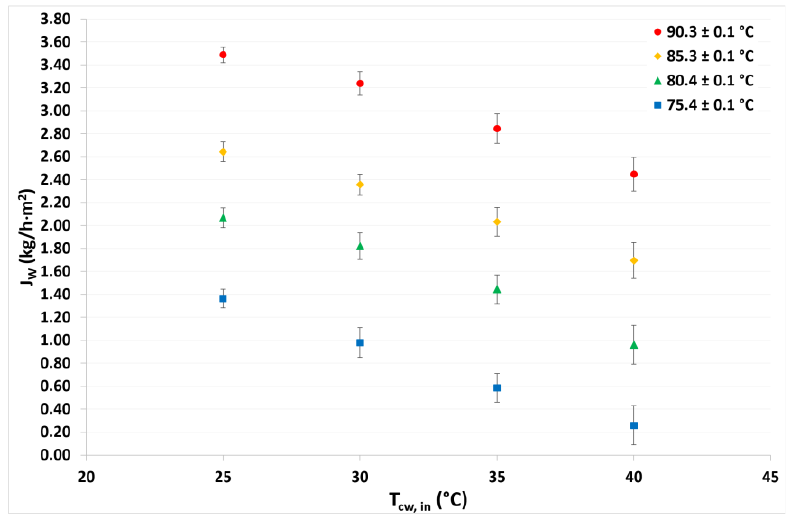
Figure 6. Desorption rate as a function of the solution and condensation temperatures.